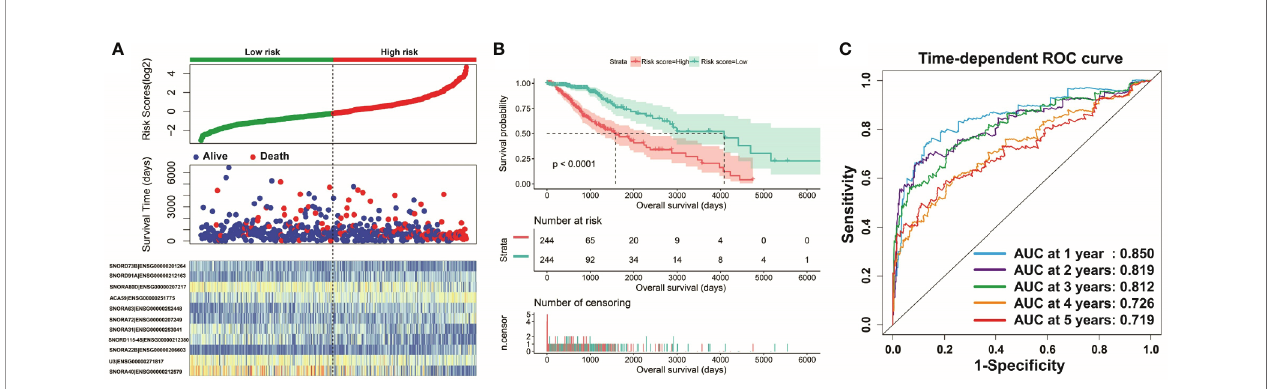
FIGURE 3 | Survival analysis of risk score. (A) Distribution of risk score and survival time of LGG patients; (B) Kaplan – Meier survival curves of risk score; (C) Time- dependent ROC curve of risk score.